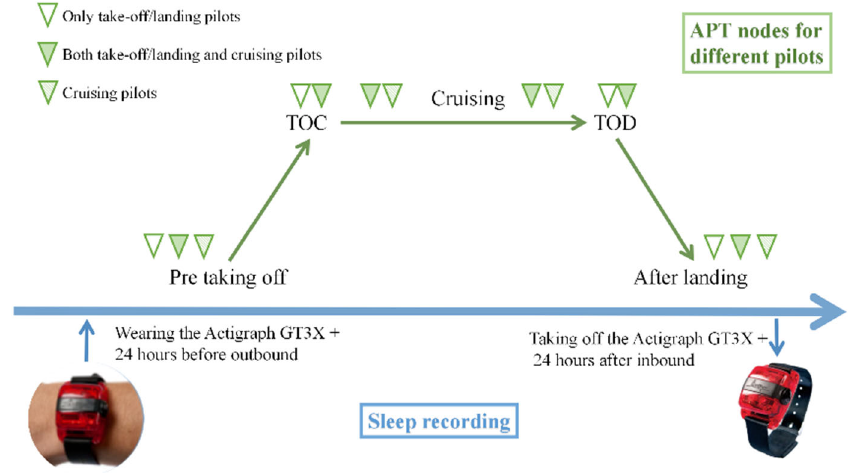
Figure 1. Data collection processes. TOC is the point when the aircraft reaches its initial cruising altitude, and TOD is the point at which the aircraft transitions from the cruise to landing phase of flight.